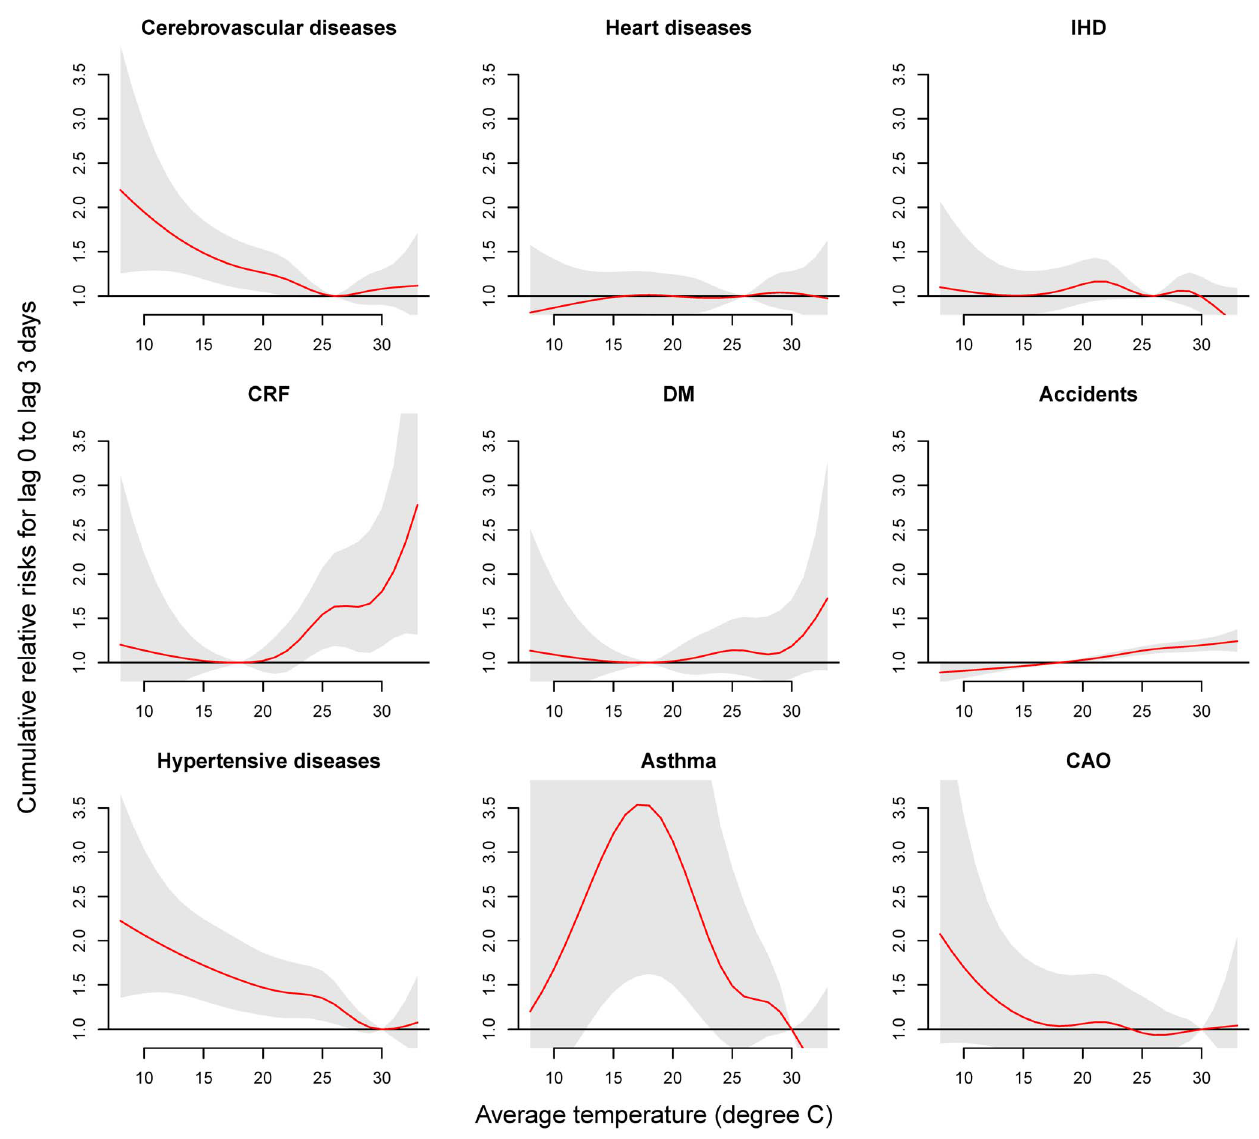
Figure 1. Associations between cause-specific emergency room visits and daily average temperatures in metropolitan Taipei from 2000 to 2009. Cumulative 4-day RRs were estimated using DLNM and a centered temperature of 26 u C for cerebrovascular diseases, 18 u C for CRF, DM, and accidents, and 30 u C for hypertensive diseases, asthma, and CAO.